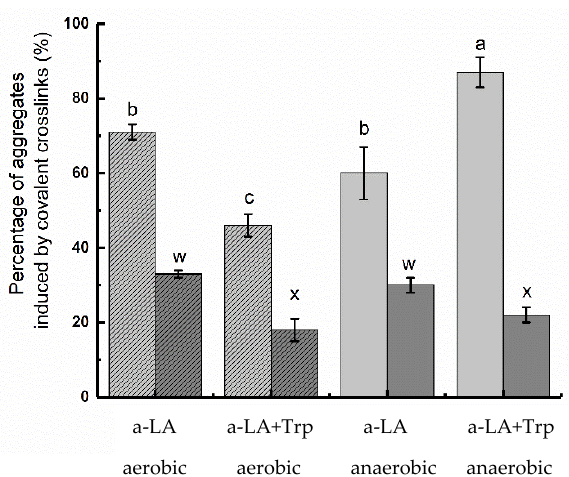
Figure 3. Covalent cross-links formed in apo- α -LA in the absence or presence of 2.8 mM Trp under aerobic and anaerobic conditions obtained after the addition of 5% SDS to disrupt non-covalent interactions. Non-reduced samples are shown in light grey bars, while samples reduced by DTT are shown in dark grey bars. Results are presented as mean values obtained from three independent experiments with standard deviations shown by error bars. Bars with different letters are significantly different.